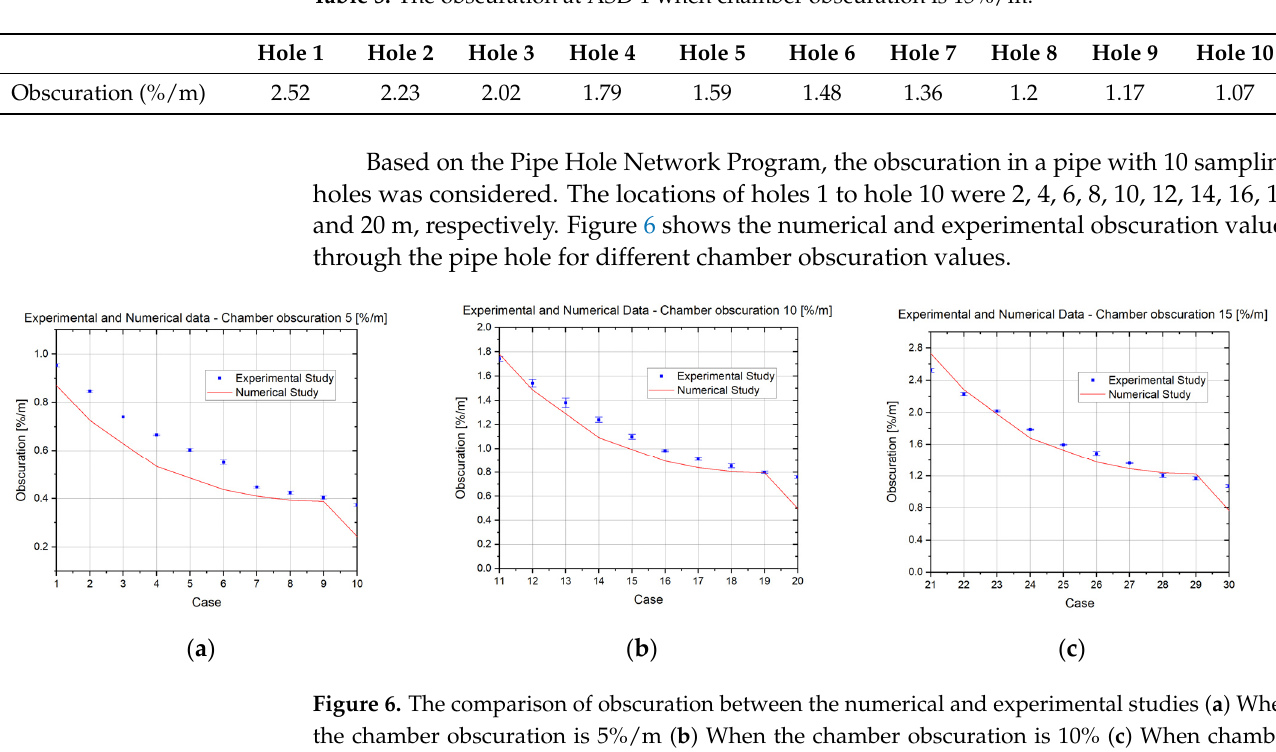
Table 5. The obscuration at ASD 1 when chamber obscuration is 15%/m.